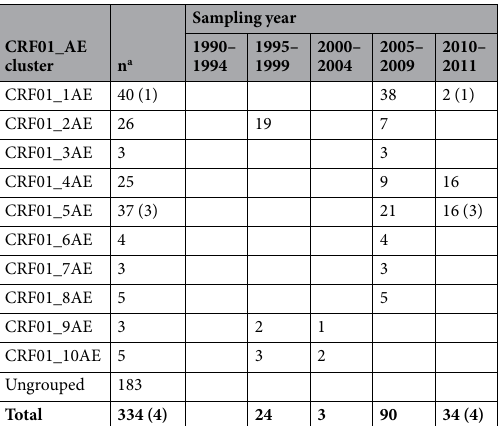
Table 3. Classification and sampling year of distinct HIV-1 CRF01_AE clusters analysed in the present study. a Numbers of HIV-1 CRF01_AE sequences newly reported in our study are shown in